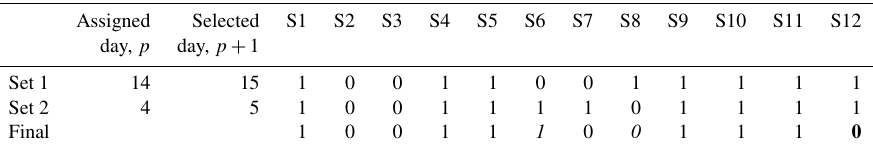
Table Appendix A4. Example for GA mixture for X c + 1 . The second and third rows present two selected sets, while the third row shows the final set for X c + 1 with the crossover at S6 and S8 and the mutation for S12. Note that the italic values are crossovers from Set 2 to Set 1 while the bold value is